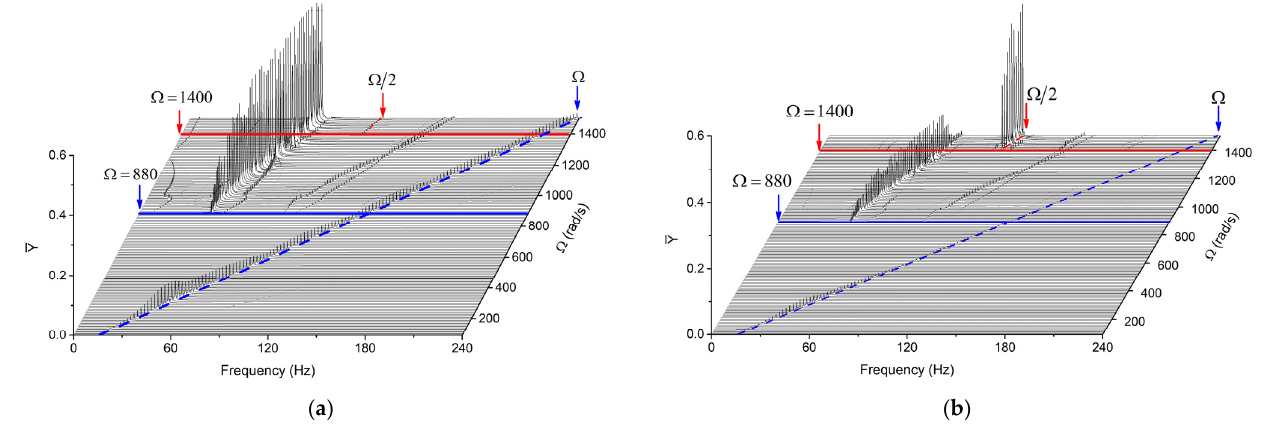
Figure 12. Cascade maps of Y-displacements: ( a ) Rotor; ( b ) Bearing.